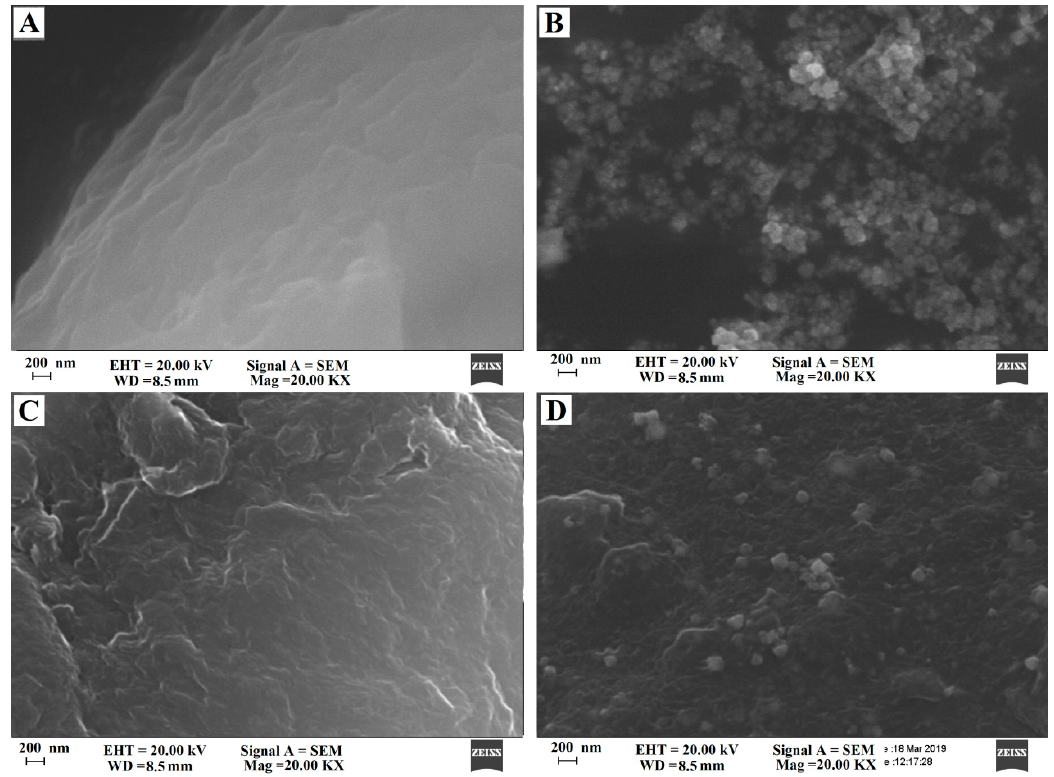
Figure 1. SEM images of ( A ) graphene oxide (GO), ( B ) Cu 2 O nanoparticles (NPs), ( C ) electrochemical reduced graphene oxide (ERGO), and ( D ) Cu 2 O NPs ‒ ERGO composites.